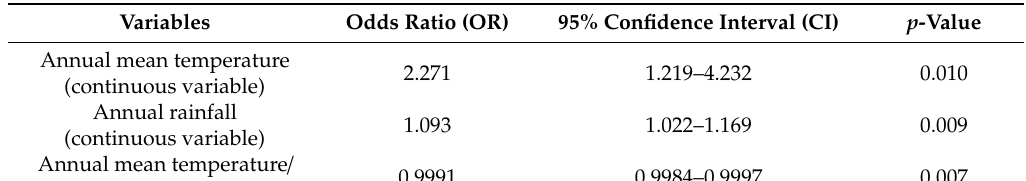
Table 2. Risk factors associated with higher Toxoplasma gondii prevalence in sheep farms using multivariate multilevel modeling.